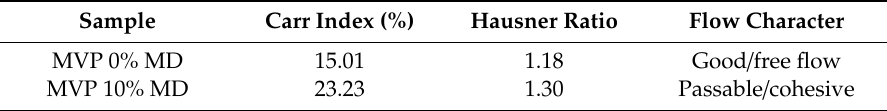
Table 5. Flowability expressed by the Carr index and Hausner